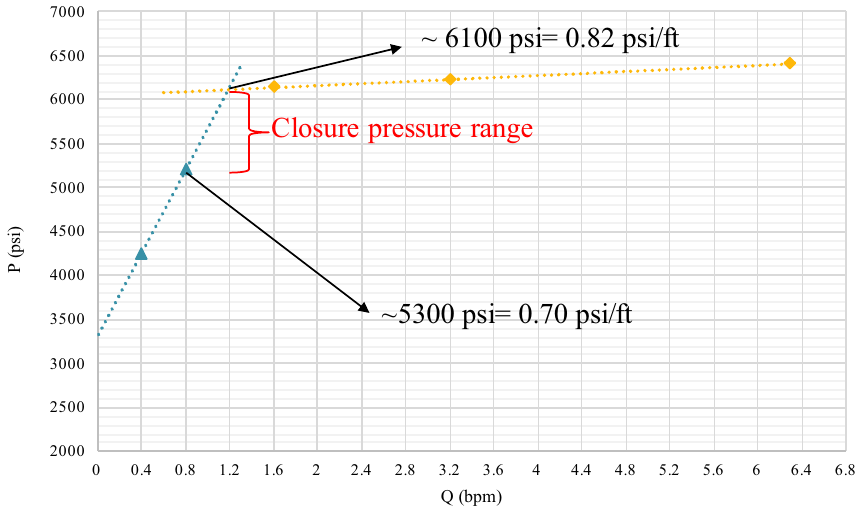
Fig. 25 A step rate test (SRT) with an extended shut-in was conducted to determine reservoir permeability and closure pressure (Cycle #7). In this cycle, 76.9 bbl freshwater was pumped in a step rate test (SRT) where rate progressively increased